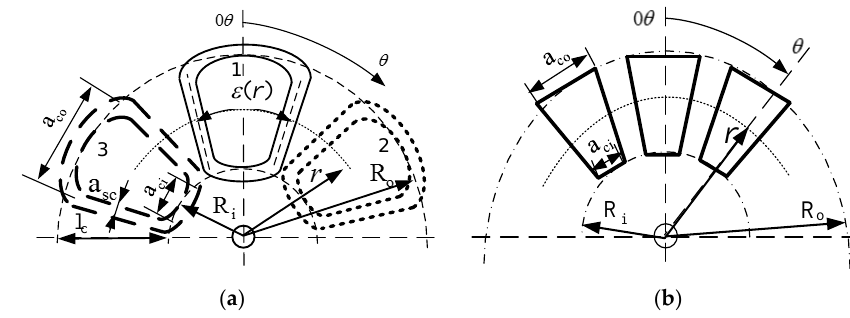
Figure 7. ( a ) Assumed winding arrangement; ( b ) the distribution of the iron cores inside the coils. The model of magnetic flux-density distribution in the air-gap of an AFPM generator is a function of four variables (dependent on a axial component z , location according to the stator θ , angle of the rotor position φ and radial location i o R R r ). It was assumed that the general equation describing the distribution of magnetic flux-density is simplified and is considered only for the axial component